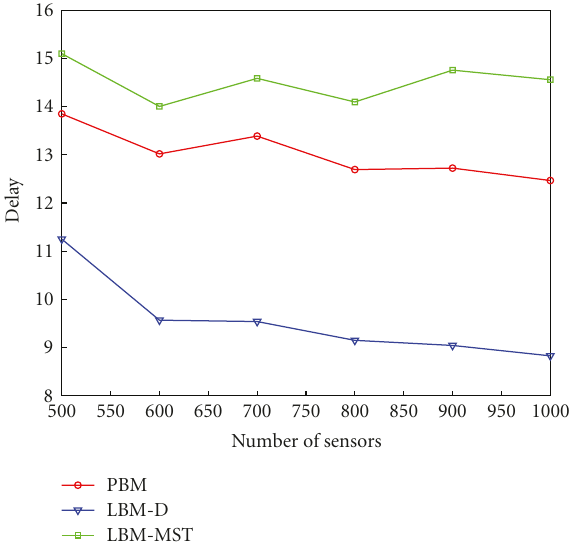
Figure 9: Average end-to-end delay for randomly located destina- tions.